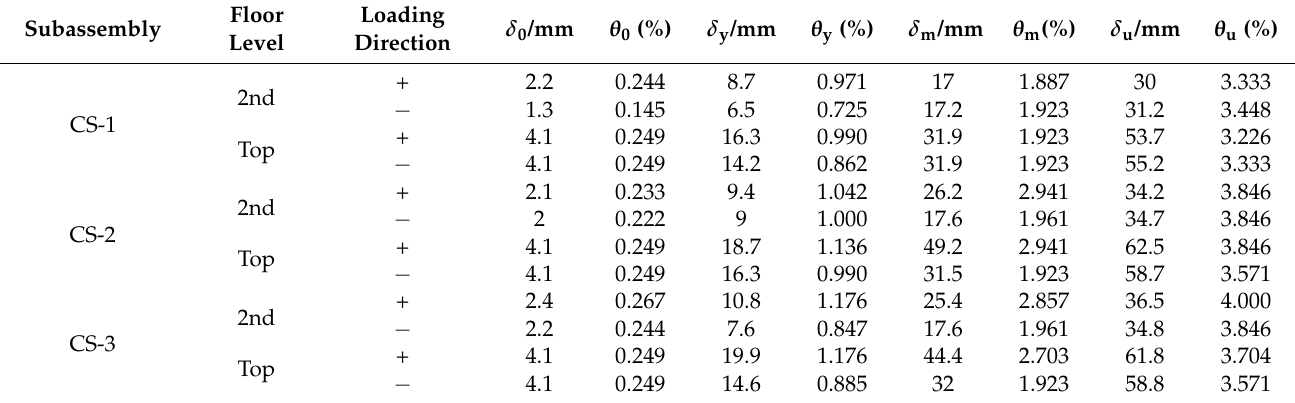
Table 4. Values of interstory drifts and interstory drift ratios.